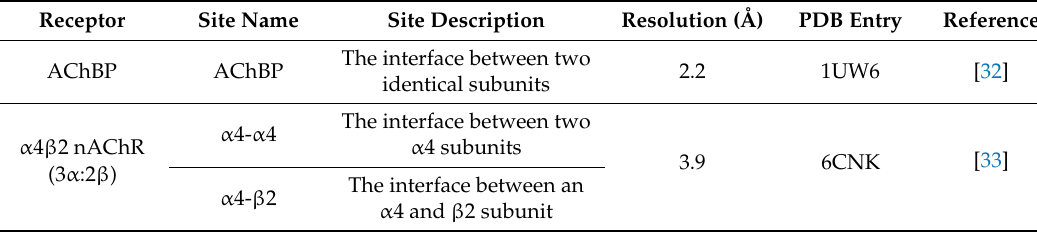
Table 1. The receptors and the binding sites used in docking experiments. Receptor Site